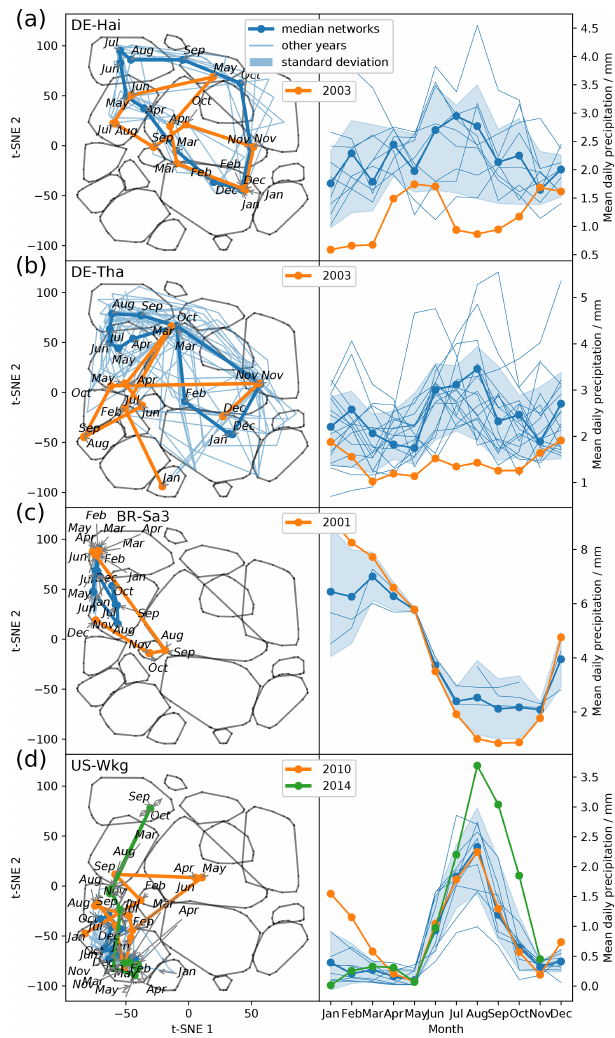
Figure 6. Abnormal conditions in meteorological conditions (here precipitation) become visible in an ecosystem’s trajectory. (a) Tra- jectories within the low-dimensional space of the ecosystems Hainich (DE-Hai, DBF), Tharandt (DE-Tha, ENF), Santarem- Km83-Logged Forest (BR-Sa3, EBF), and Walnut Gulch Kendall Grasslands (US-Wkg, GRA); (b) 3-monthly average of daily pre- cipitation